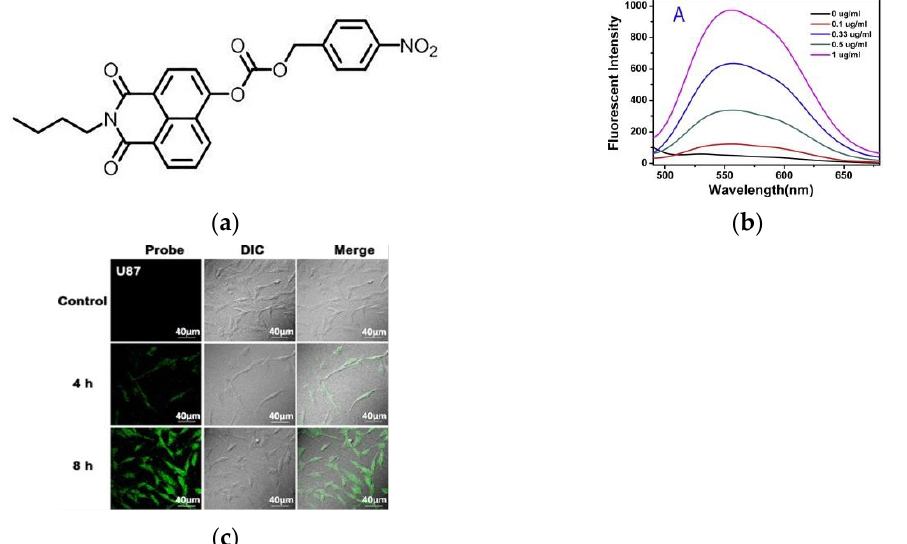
Figure 8. ( a ) Structure of probe 2; ( b ) Fluorescence intensity of the probe reacted in the presence of NTR; ( c ) Laser confocal fluorescence images of U87 cells under the condition of normoxic (20% O 2 ) and hypoxic (1% O 2 ). Reproduced with permission from [60]. Copyright 2017 Elsevier B.V.